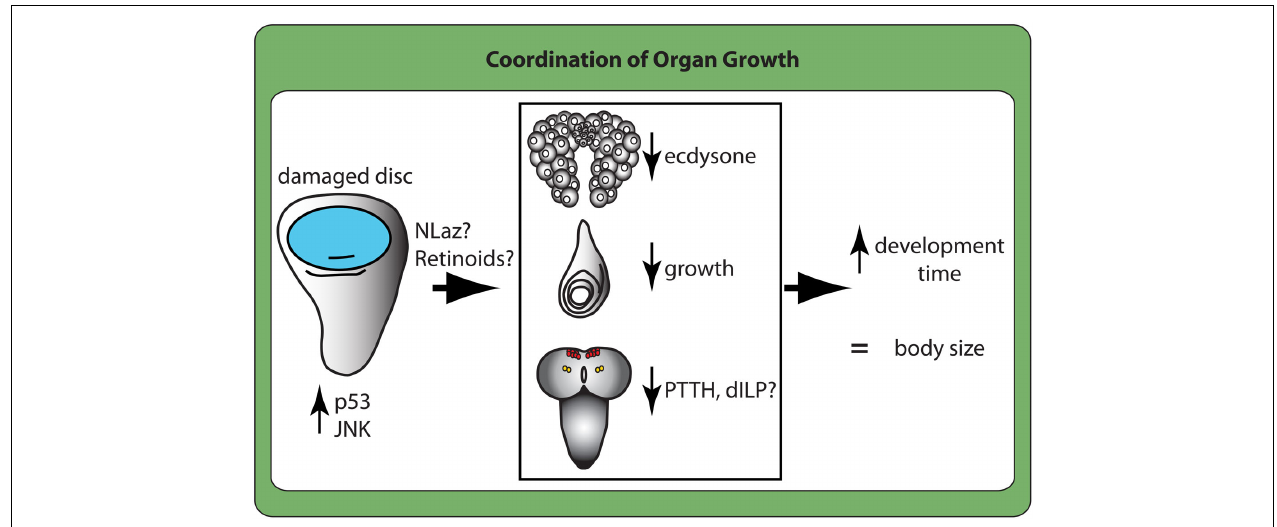
synthesis by the prothoracic gland (top tissue in box), reduces growth of another normally growing disks (leg disk in middle), and reduces PTTH (PTTH cells in yellow) and may reduce the production of insulin like peptides (dILP) from the insulin producing cells (in red) in the brain (bottom tissue). In this manner, growth-perturbed disks delay development although the larvae eventually metamorphose to produce normally sized